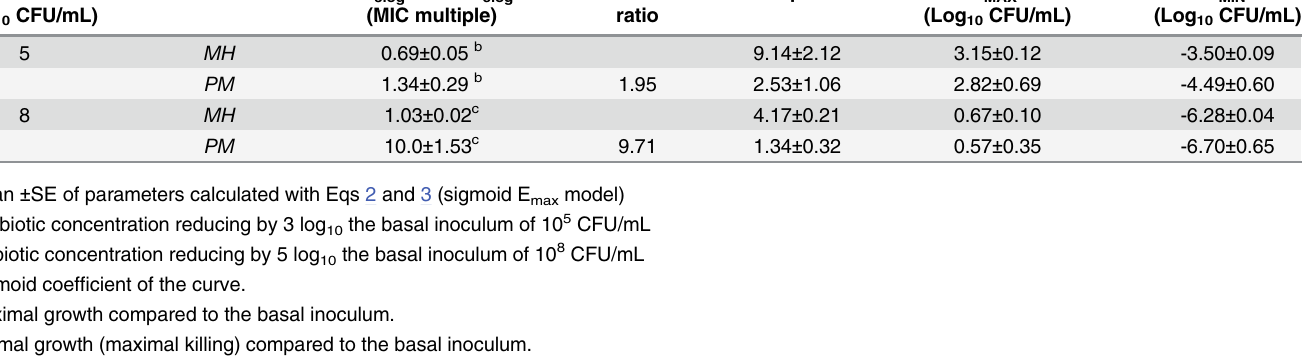
Table 2. Pharmacodynamic parameters a describing the antimicrobial activity of marbofloxacin against different inoculum sizes of M . haemolytica (MH) and P . multocida (PM) in BHIB. Basal inoculum